Question: State the chart type depicted above.
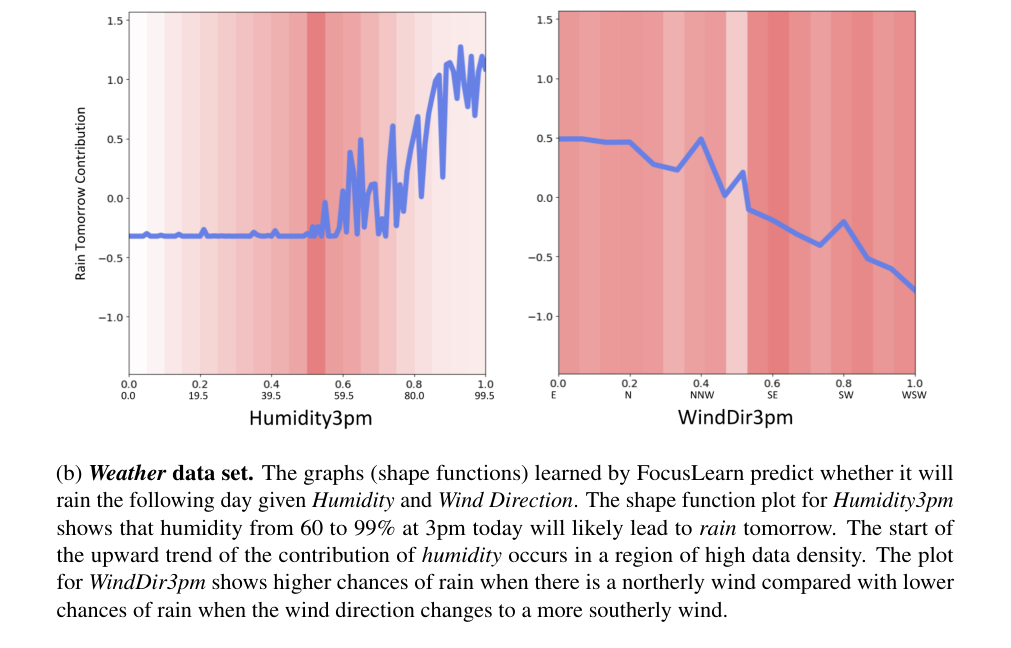
Answer: bar